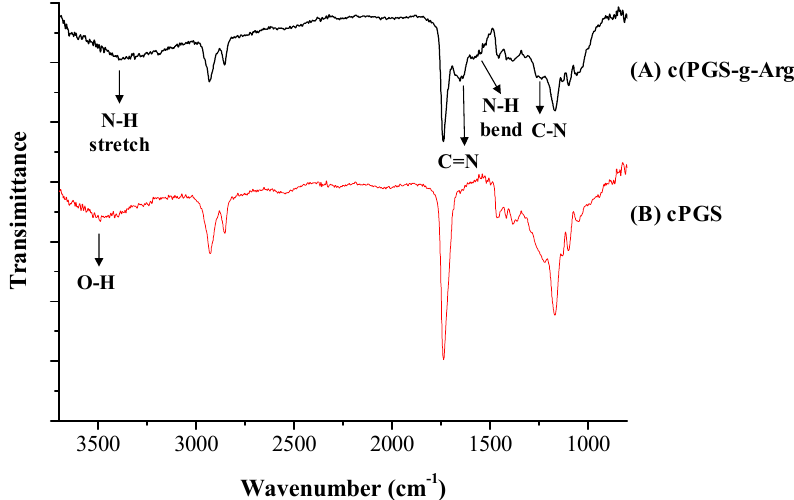
Figure 3. Attenuated Total Reflection-Fourier transform infrared (ATR-FTIR) spectra of ( A ) crosslinked PGS-g-Arg film (c(PGS-g-Arg)) and ( B ) crosslinked PGS film (c(PGS)).